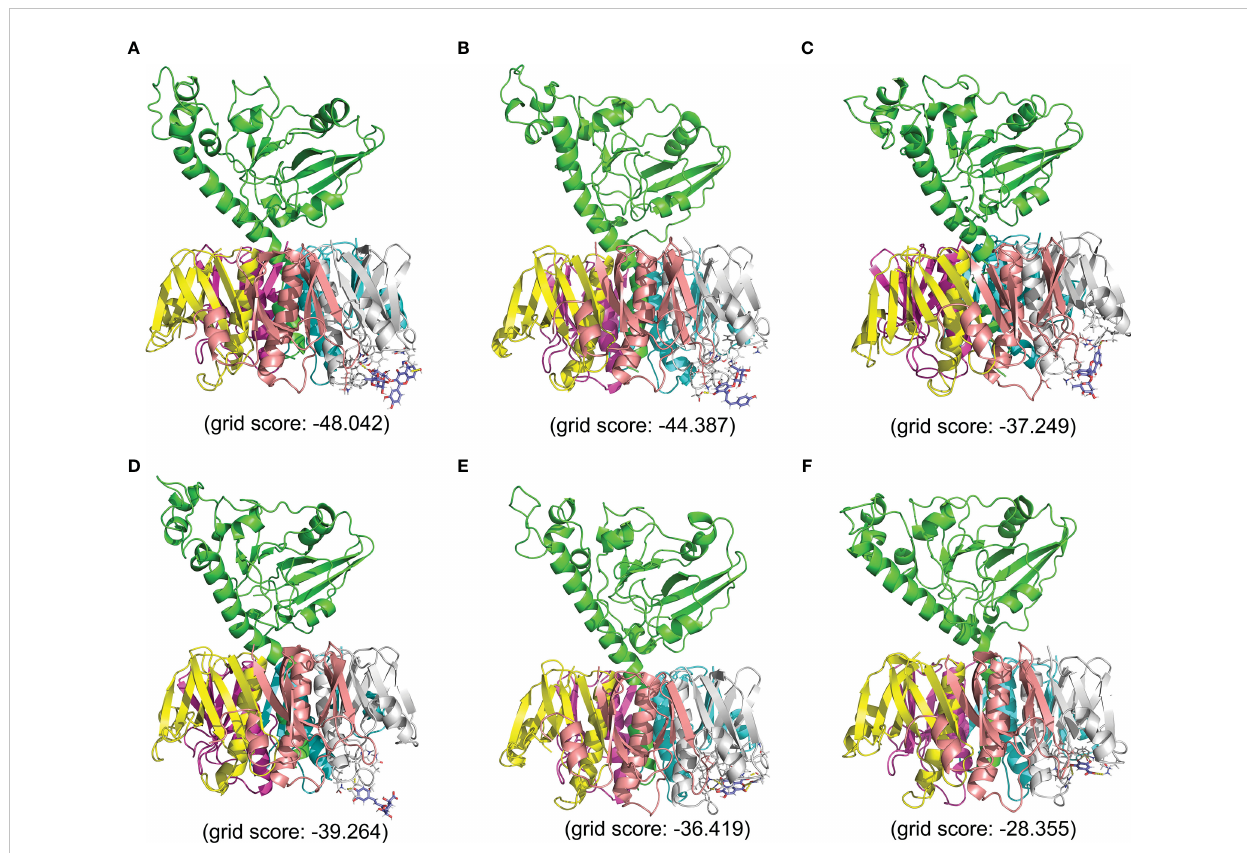
FIGURE 2 The 3D representation of binding mode and the interactions of the six selected compounds with 1XTC with their respective grid score. (A) CT-RTN, (B) CT-PHD, (C) CT-QRTN, (D) CT-CHL, (E) CT-EA, (F)